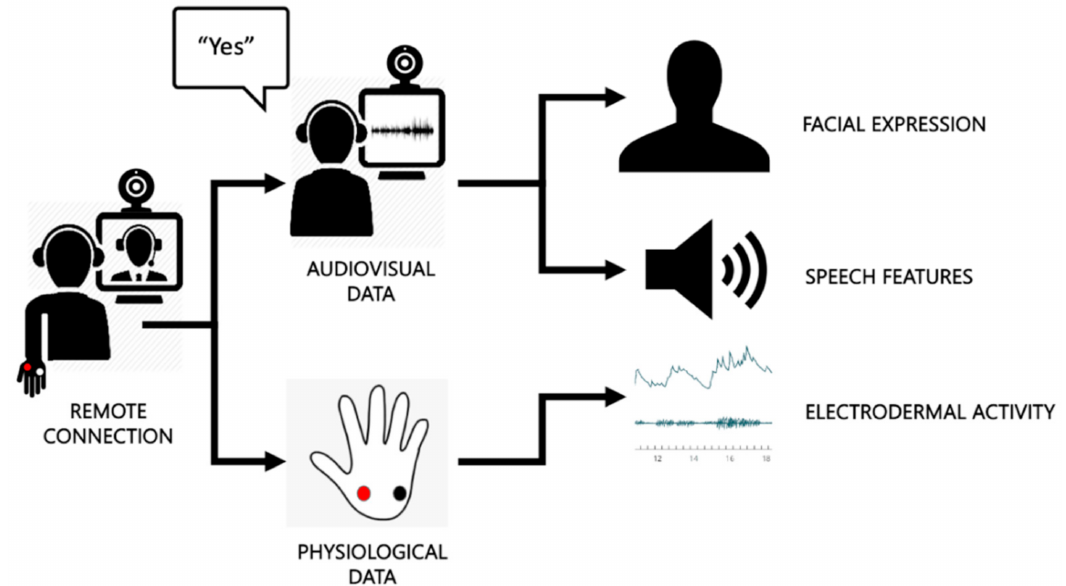
Figure 2. An overview illustration of the experimental